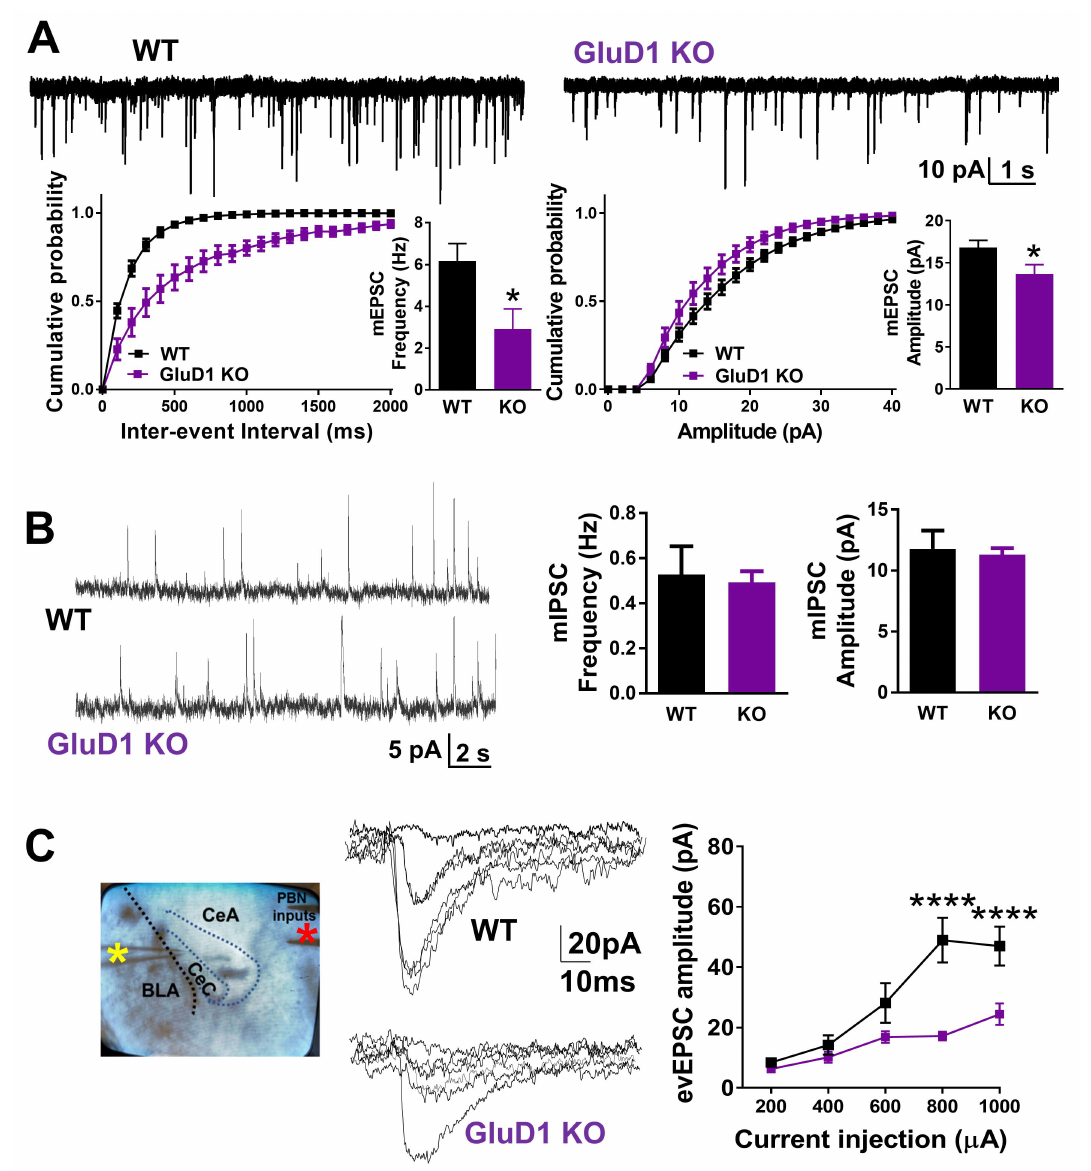
Figure 2. GluD1 is critical for regulating excitatory neurotransmission at parabrachio-amygdala synapses. ( A ) Whole-cell mEPSC recordings at − 70mV (in the presence of picrotoxin and tetrodotoxin) from CeC neurons demonstrate significantly lower mEPSC frequency and amplitude in GluD1 KO (WT ( n = 8) vs. GluD1 KO ( n = 9): Frequency: 6.17 ± 0.83 Hz vs. 2.91 ± 0.96 Hz, * p = 0.022, two-tailed unpaired t-test with Welch’s correction; Amplitude: 16.78 ± 0.869 pA vs. 13.66 ± 1.124 pA, * p = 0.045, unpaired t -test). ( B ) No change in mIPSC frequency and amplitude in CeC due to deletion of GluD1 (Frequency: p = 0.74, Amplitude: p = 0.77; two-tailed unpaired t-test, n = 8). ( C ) Whole-cell evoked EPSCs from CeC neurons at -70 mV in the presence of picrotoxin with recording electrode in CeC (yellow asterisk) and stimulating electrode on PB fibers (red asterisk). The input–output curve shows significant reduction in evoked EPSC amplitude in GluD1 KO mice. (Two-way repeated measures ANOVA, genotype F (1, 28) = 23.03, p < 0.0001; Bonferroni’s multiple comparisons test: WT ( n = 15) vs. GluD1 KO ( n = 25); 800 µ A current injection: 48.97 ± 7.39 vs. 17.16 ± 1.43, **** p < 0.0001; 1 mA current injection: 47.00 ± 6.40 vs. 24.46 ± 3.56, **** p <